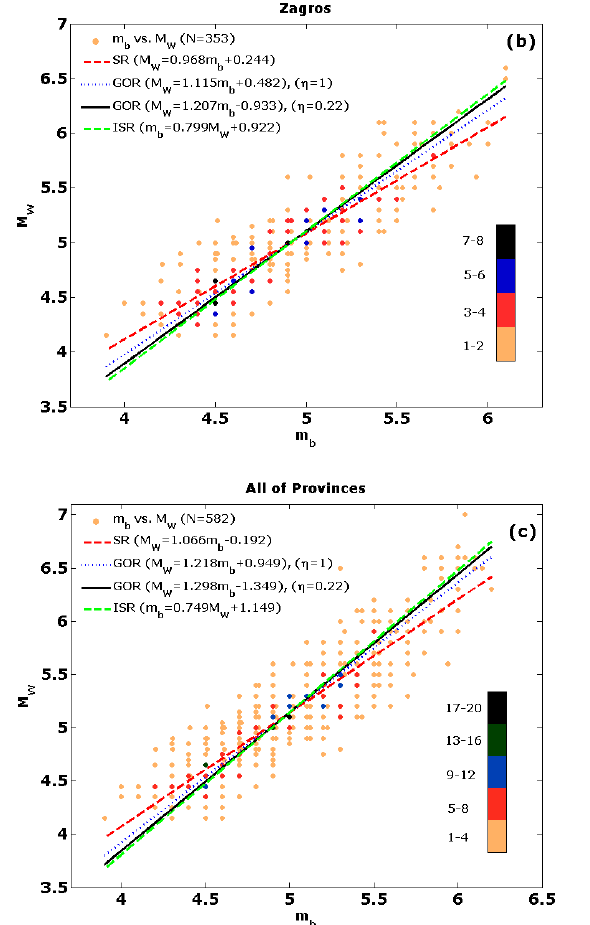
–M conversion relations for b w